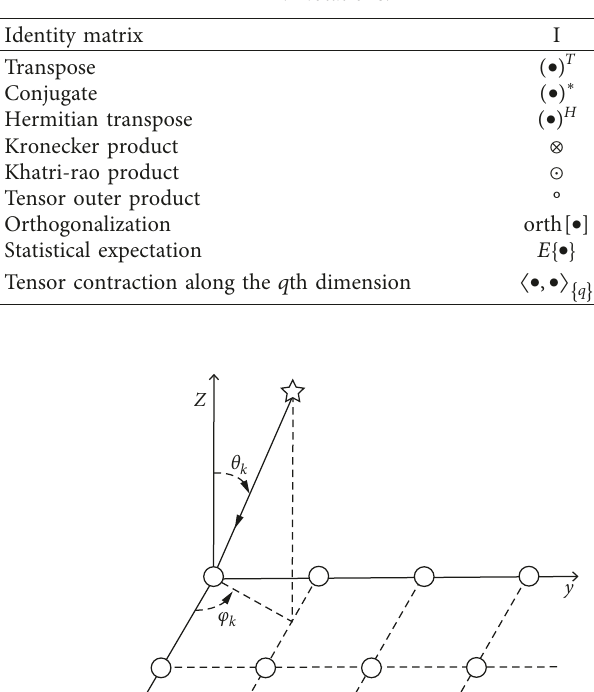
Table 1: Notations.